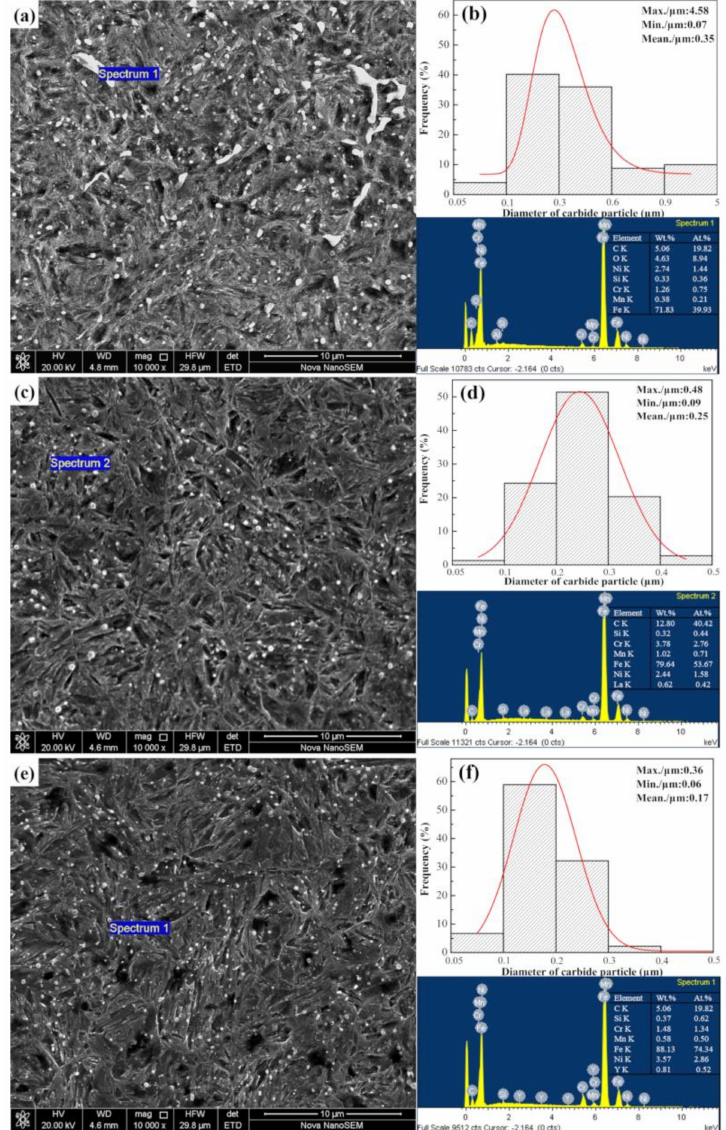
Figure 10. Diameter of the granular carbides in the carburized surface layer—( a ) carbide morphology and energy dispersive spectroscopy (EDS) results without RE and ( b ) its carbide diameter distribution; ( c ) carbide morphology and EDS results with La implantation and ( d ) its carbide diameter distribution; ( e ) carbide morphology and EDS results with Y implantation, and ( f ) its carbide diameter